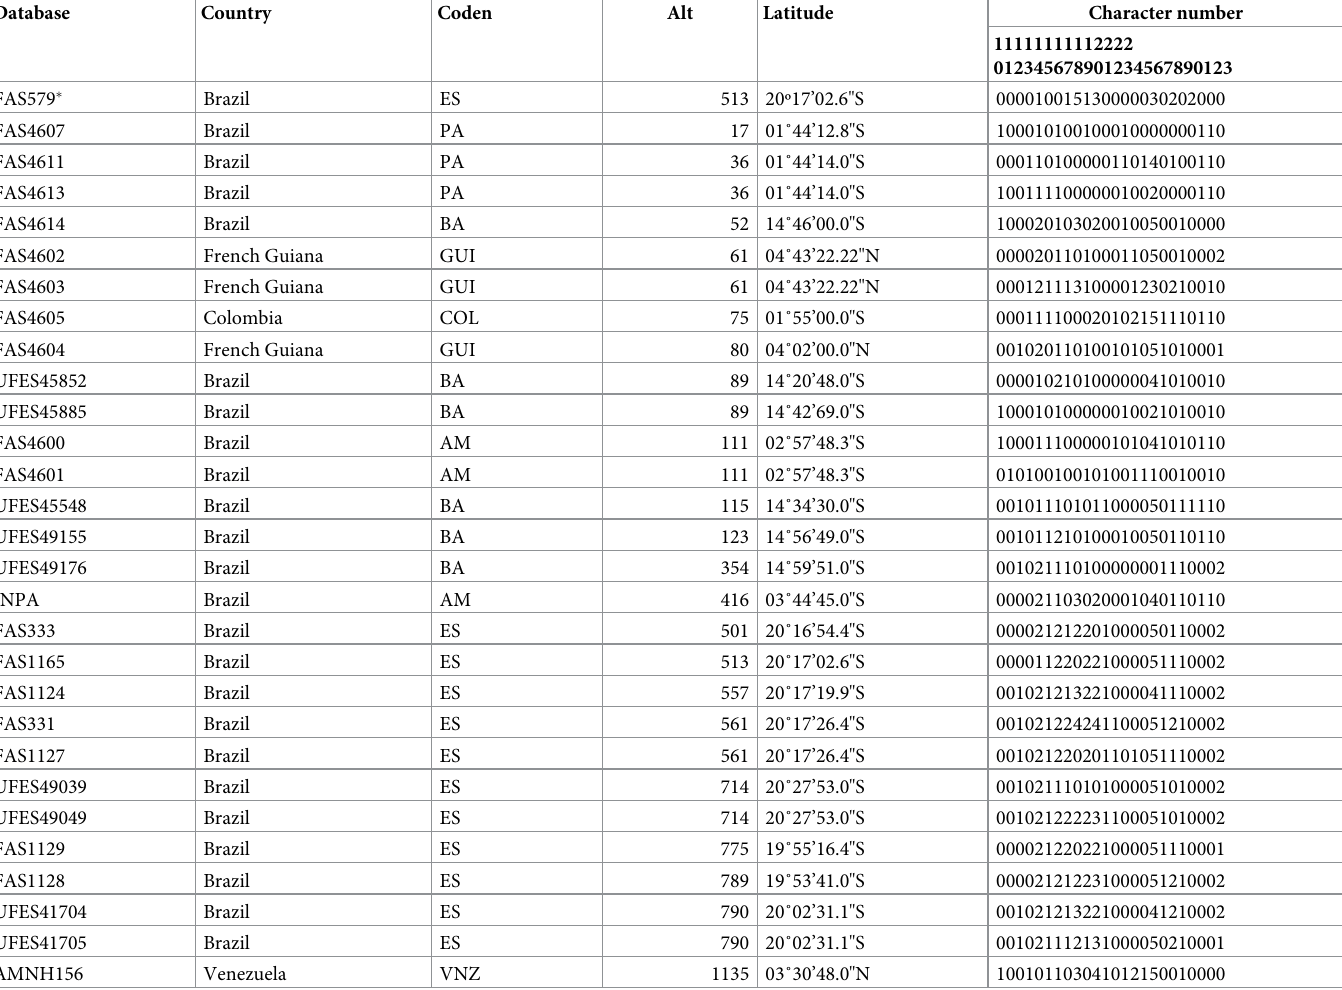
Table 4. Data matrix used in the analyses of morphological variation. Coding reflects all variation observed for all available females of Cryptoxenodon metamorphus sp . nov . First specimen (FAS579 � ) is a Diapetimorpha sp., used as outgroup; other specimens ordered from the lowest to the highest altitude. Alt , altitude, in meters; Coden , State abbreviations (Brazil) or coden for the